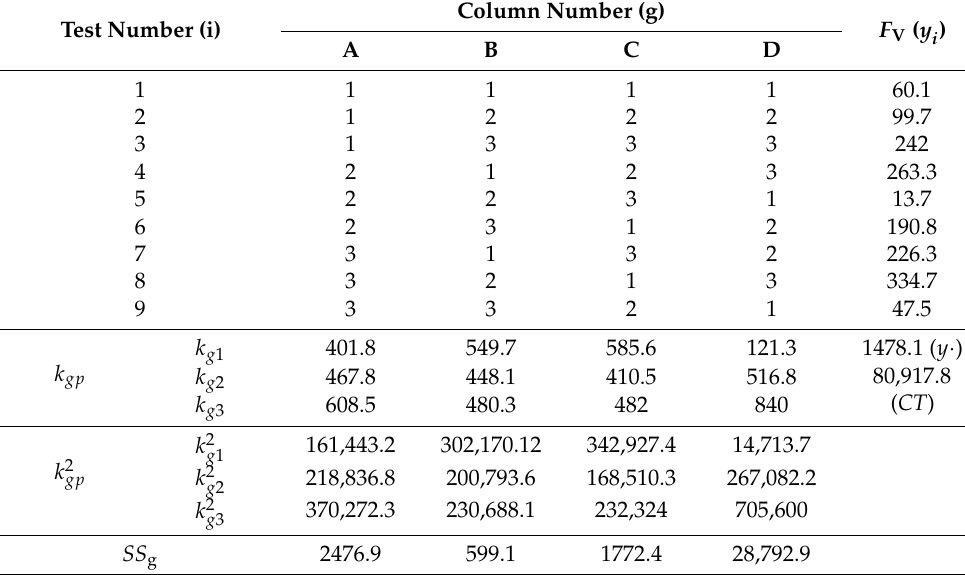
Table 7. Data processing results of cutting force in the vertical direction.